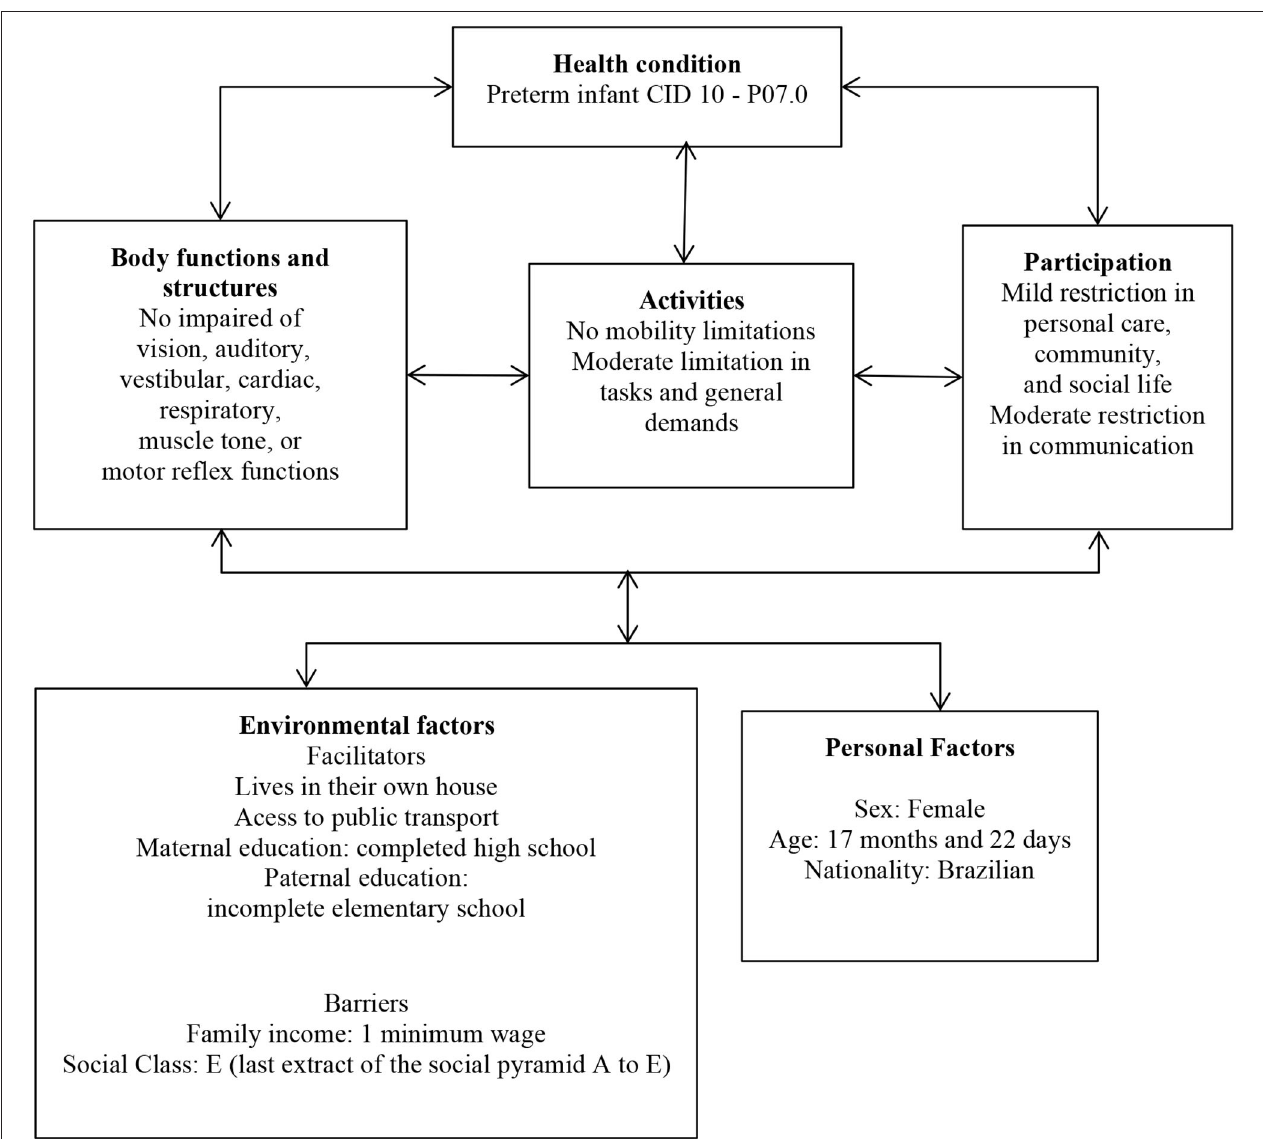
FIGURE 1 | Flowchart of interactions between variables according to the International Classification of Functioning, Disability, and Health at 17 months and 22 days of